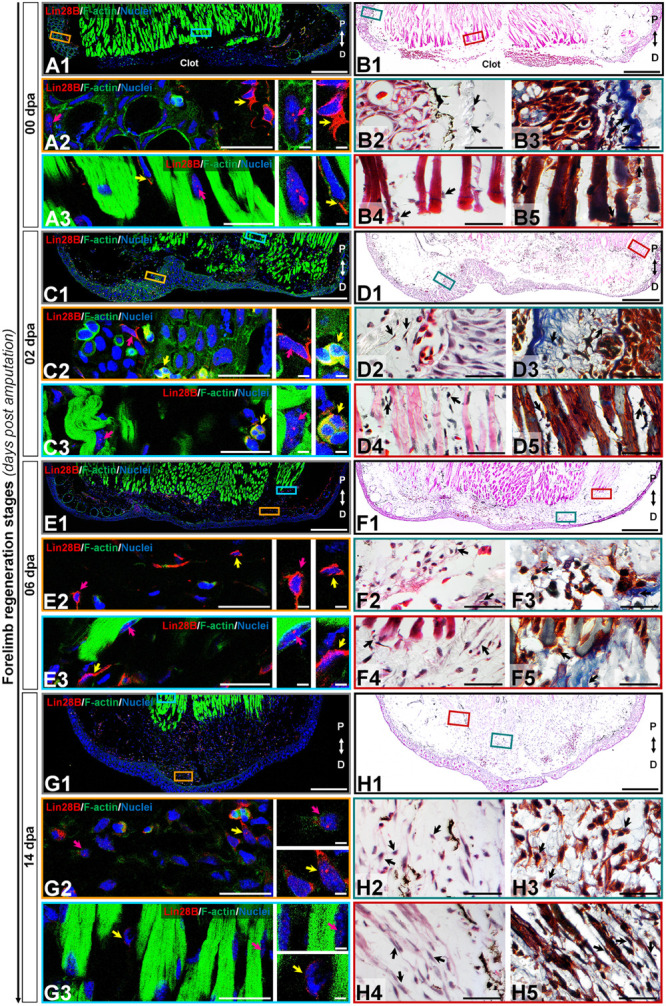
Subcellular immunolocalization of amxLin28B during forelimb regeneration. (A–H) Histological sections of representative stages during the limb regeneration oriented in the Proximal-Distal axis. (A,B) Uninjured limb (00 dpa). (C,D) Wound healing stage (02 dpa). (E,F) Apical epidermal cap stage (06 dpa). (G,H) Early blastema stage (14 dpa). (A1,C1,E1,G1) Intracellular localization dynamics of amxLin28B marked in red, by contrast with DAPI (blue) and Phalloidin (green) that delimit nuclei and cell shapes, respectively. Scale bars: 500 μm. (A2-3,C2-3,E2-3,G2-3) Magnifications with different color contours to remark some areas of interest for amxLin28B in red, DAPI in blue, and Phalloidin in green; arrows in yellow and magenta have in turn their own zoom in. Scale bars: 50 and 5 μm, respectively. (B1,D1,F1,H1) The architectural organization of tissues is shown with Hematoxylin and Eosin staining. Scale bars: 500 μm. (B2/4,D2/4,F2/4,H2/4) Magnifications with distinct color contours to indicate some areas of interest in Hematoxylin and Eosin staining. Scale bars: 50 μm. (B3/5,D3/5,F3/5,H3/5) Histological changes detected on extracellular matrix for similar zones indicated in H&E ampliations, which are displayed with a differential staining to connective tissue. Scale bars: 50 μm. The different arrows indicate diverse tissue components, as described in results.